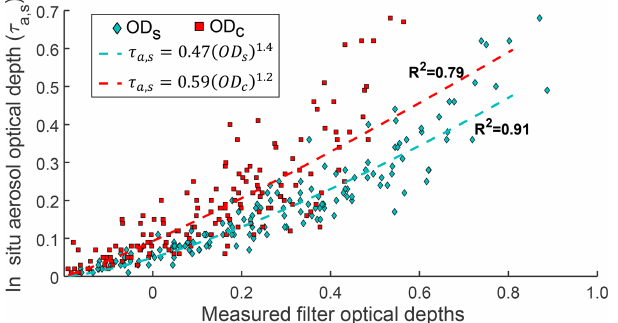
Figure 8. Correction factor C for filter artifacts as a function of sin- gle scattering albedo of the deposited aerosols. Error bars show 1 SD around the mean. The numbers in parentheses denote the num- ber of data points in each